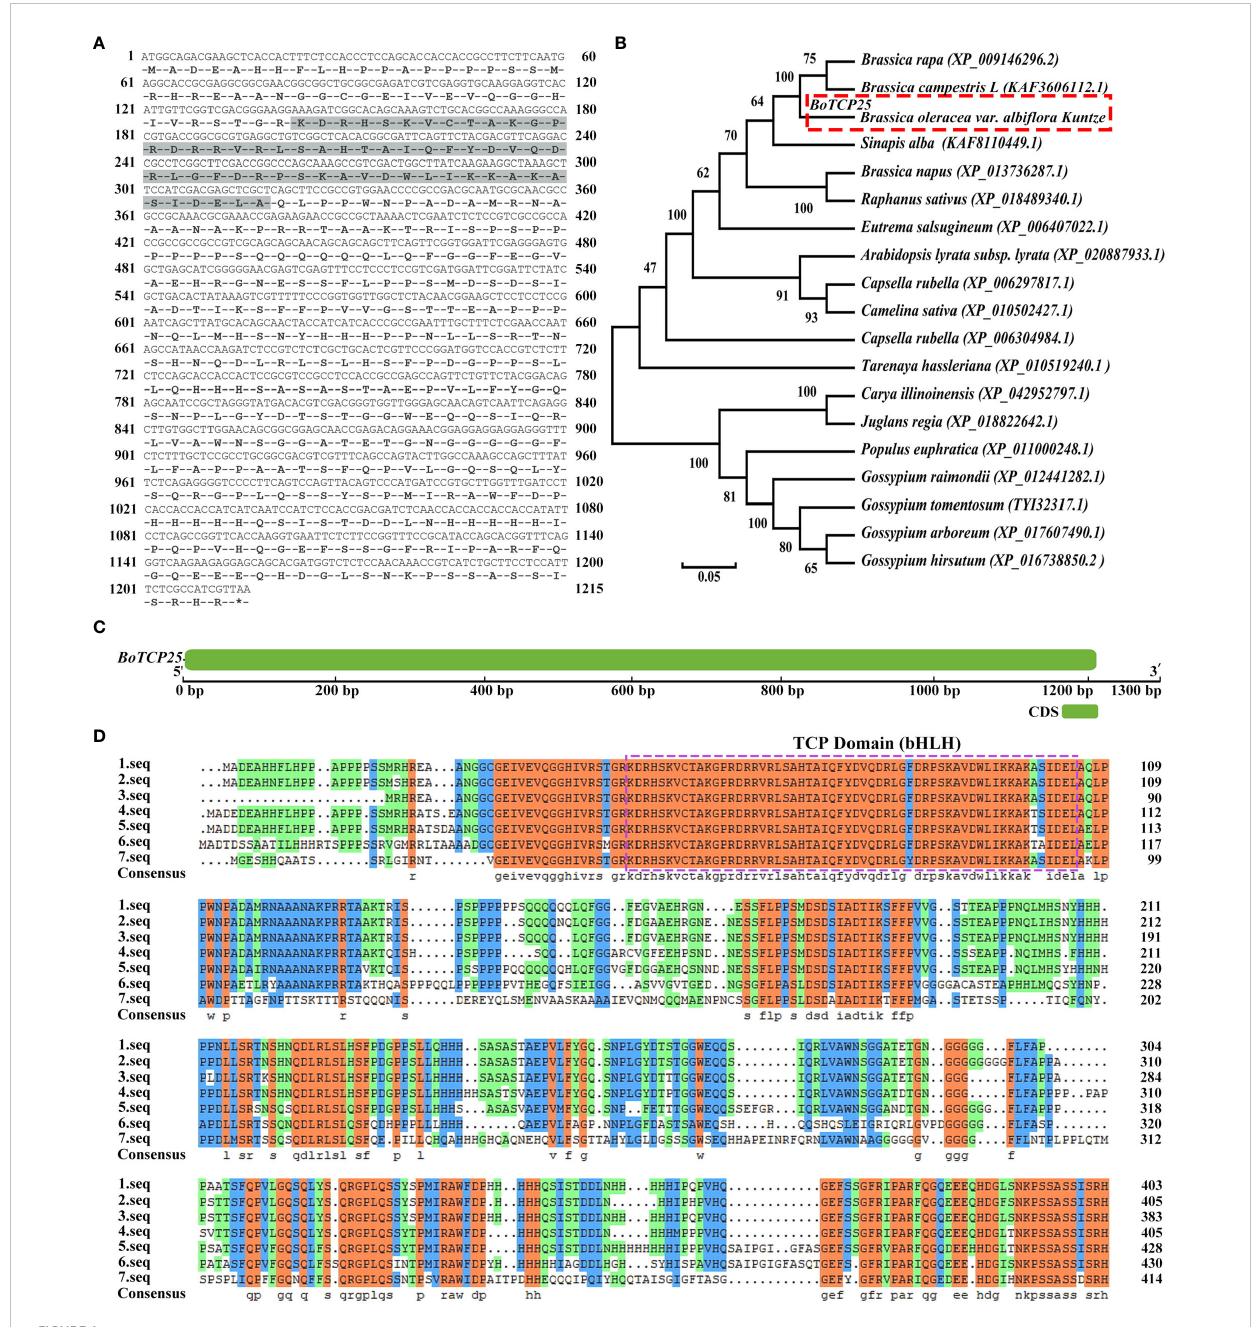
FIGURE 1 Bioinformatics analysis of BoTCP25. (A) Amino acid sequence encoded by BoTCP25 (the shaded area is the conserved region), (B) Phylogenetic tree of BoTCP25 and its homologous proteins in other species, (C) Gene structure of BoTCP25, (D) Multiple sequence alignment map of BoTCP25 and its homologous proteins in different species. 1. seq: Brassica oleracea ; 2. seq: Brassica rapa ; 3. seq: Brassica campestris L ; 4. seq: Sinapis alba ; 5. seq: Eutrema salsugineum ; 6. seq: Tarenaya hassleriana ; 7. seq: Populus euphratica